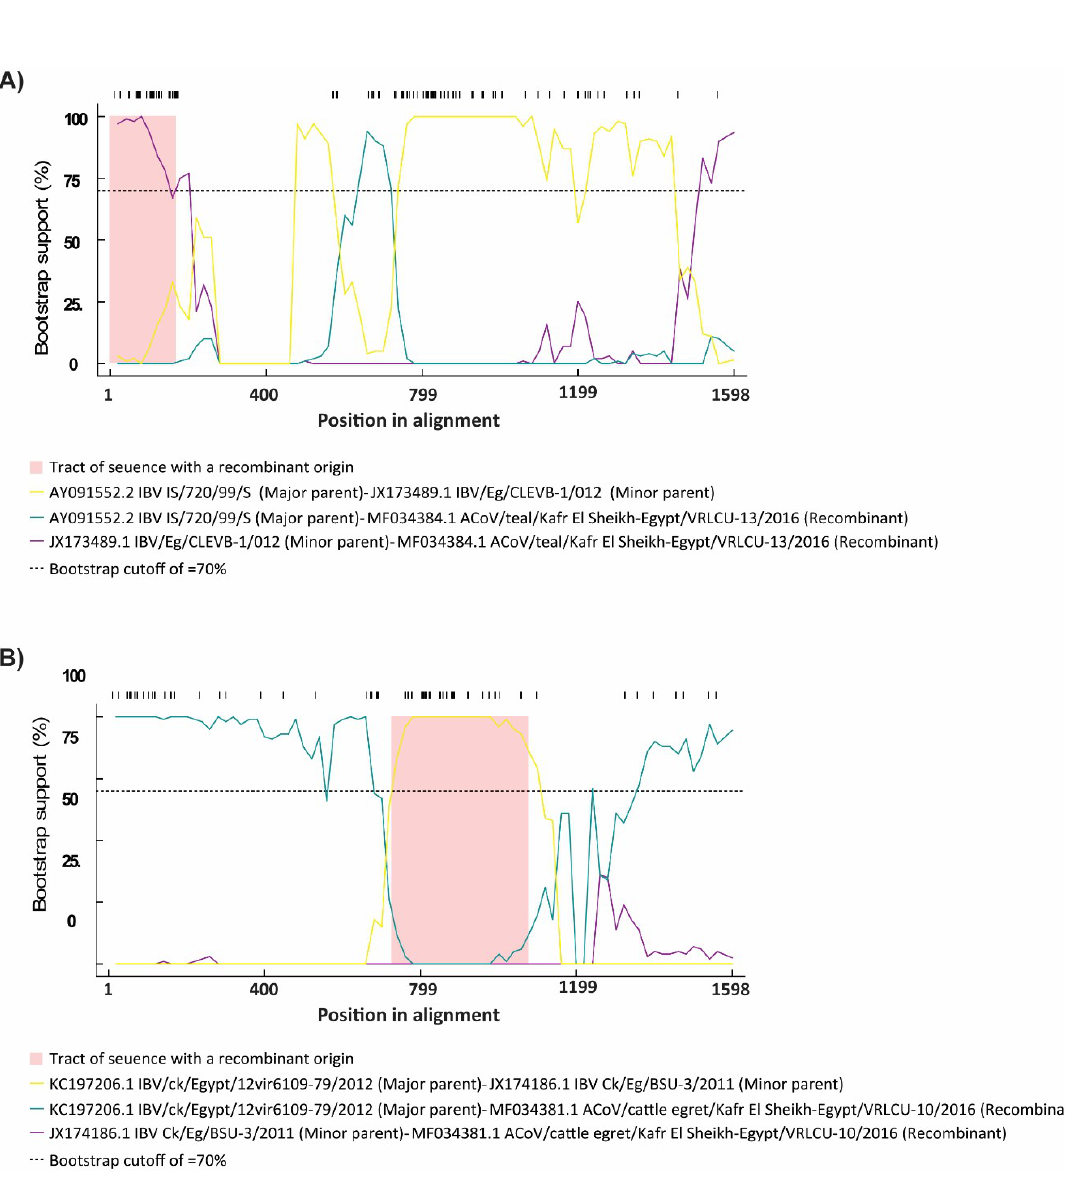
Figure 6. Recombination detection analysis displaying possible recombination events predicted to have occurred in the S1 segment of the ( A ) MF034384.1 ACoV/teal/Kafr El Sheikh-Egypt/VRLCU-13/2016 and ( B ) MF034381.1 ACoV/cattle egret/Kafr El Sheikh-Egypt/VRLCU-10/2016